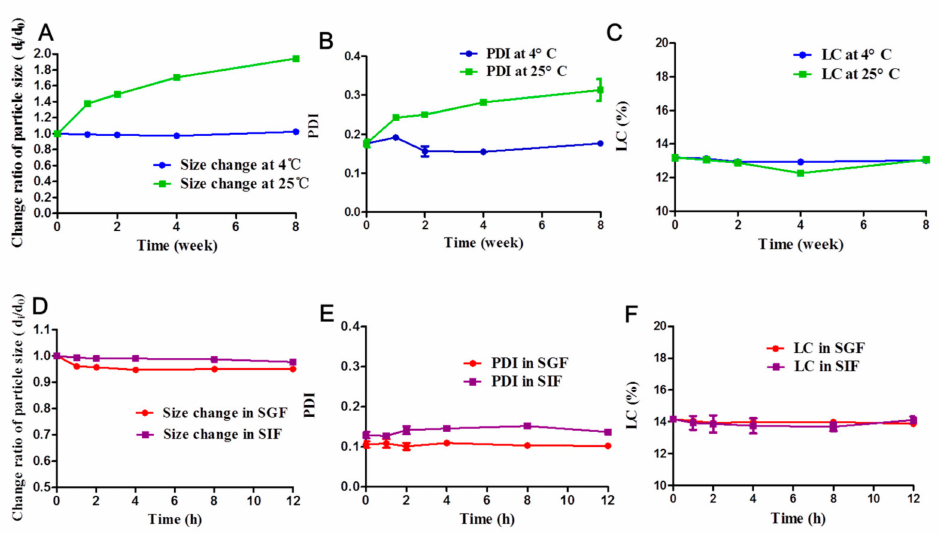
Figure 4. Changes in particle size ( A , D ), PDI ( B , E ) and LC ( C , F ) of IPMs with temperature ( A – C ) and physiological conditions ( D – F ). LC, drug loading content; IPMs, icaritin-loaded polymeric micelles; PDI, polydispersity